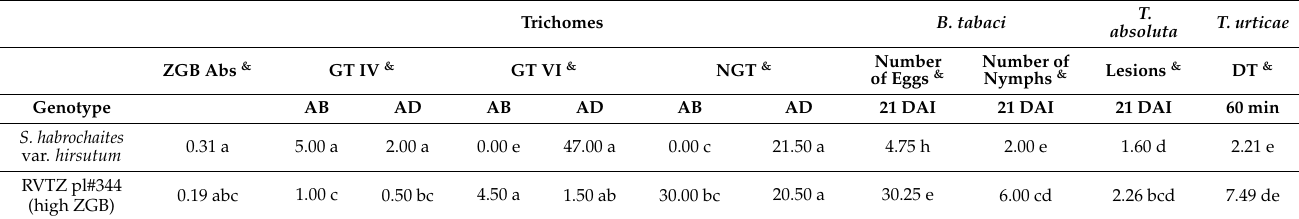
Table 2. Correlation between zingiberene (ZGB) concentration and type and amount of trichomes with intensity of infestation by Bemisia tabaci , Tuta absoluta , and Tetranychus urticae in BC 3 F 2 tomato genotypes obtained from a cross between Solanum lycopersicum cv. Redeç ã o (used as the default susceptibility genotype) and Solanum habrochaites var. hirsutum (PI127826) (used as the